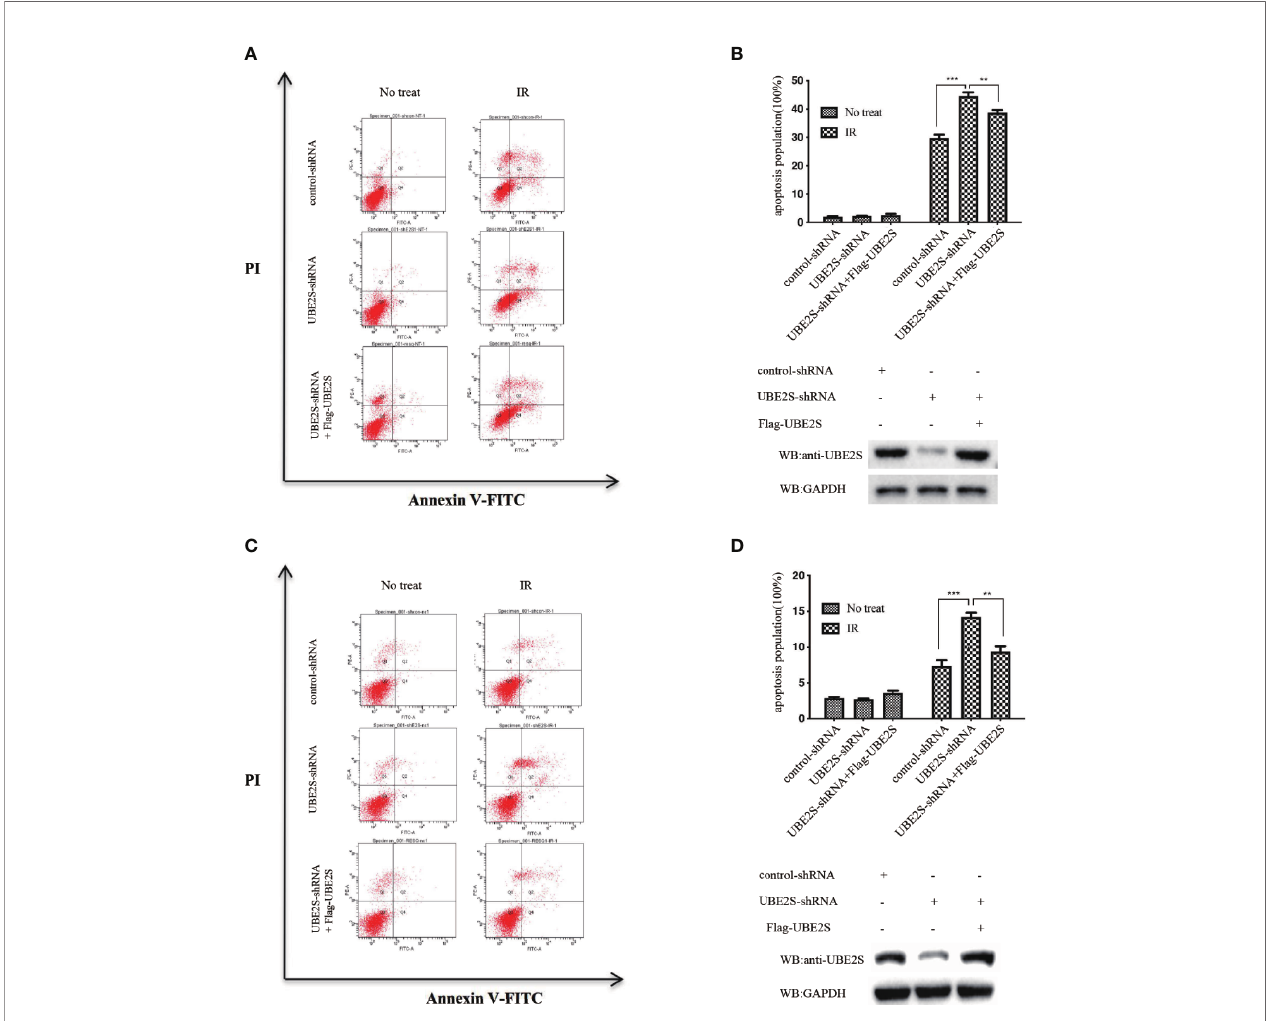
FIGURE 7 | Knockdown of UBE2S expression increases sensitivity of U87 and U251 cells to IR-induced apoptosis. (A) Indicated cells were treated with IR, and apoptotic cells were analyzed using FACS. (B) The upper panel shows the graphical representation of FACS analysis in (A) . Results are derived from three independent experiments and presented as mean ± SEM. ***P < 0.001, **P < 0.01. The lower panel shows the protein expression levels as indicated. (C) Indicated cells were treated with IR, and apoptotic cells were analyzed using FACS. (D) The upper panel shows the graphical representation of the FACS analysis in (C) . Means represent three independent experiments. Error bars indicate SEM. ***P < 0.001, **P < 0.01. The lower panel shows the protein expression levels as indicated. Statistical differences were determined by